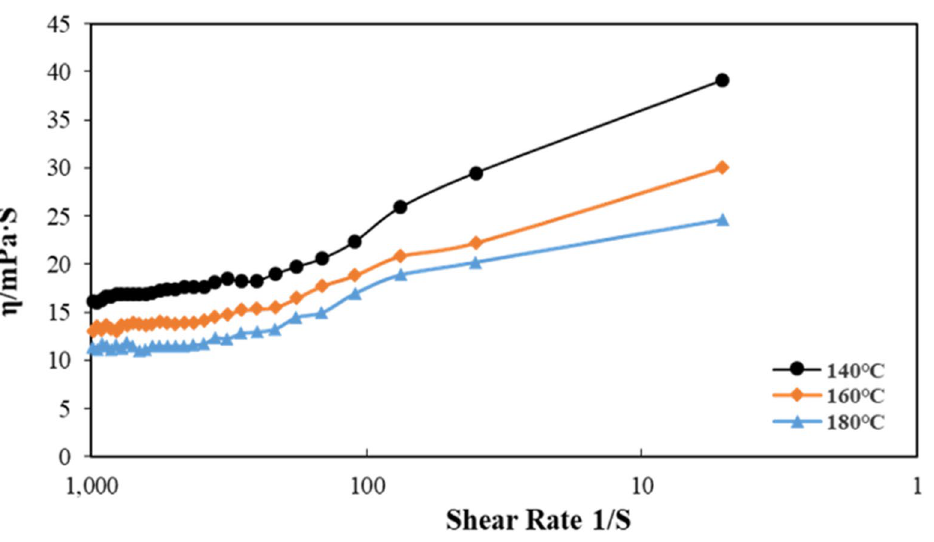
Figure 6. Dynamic rheology experiment of